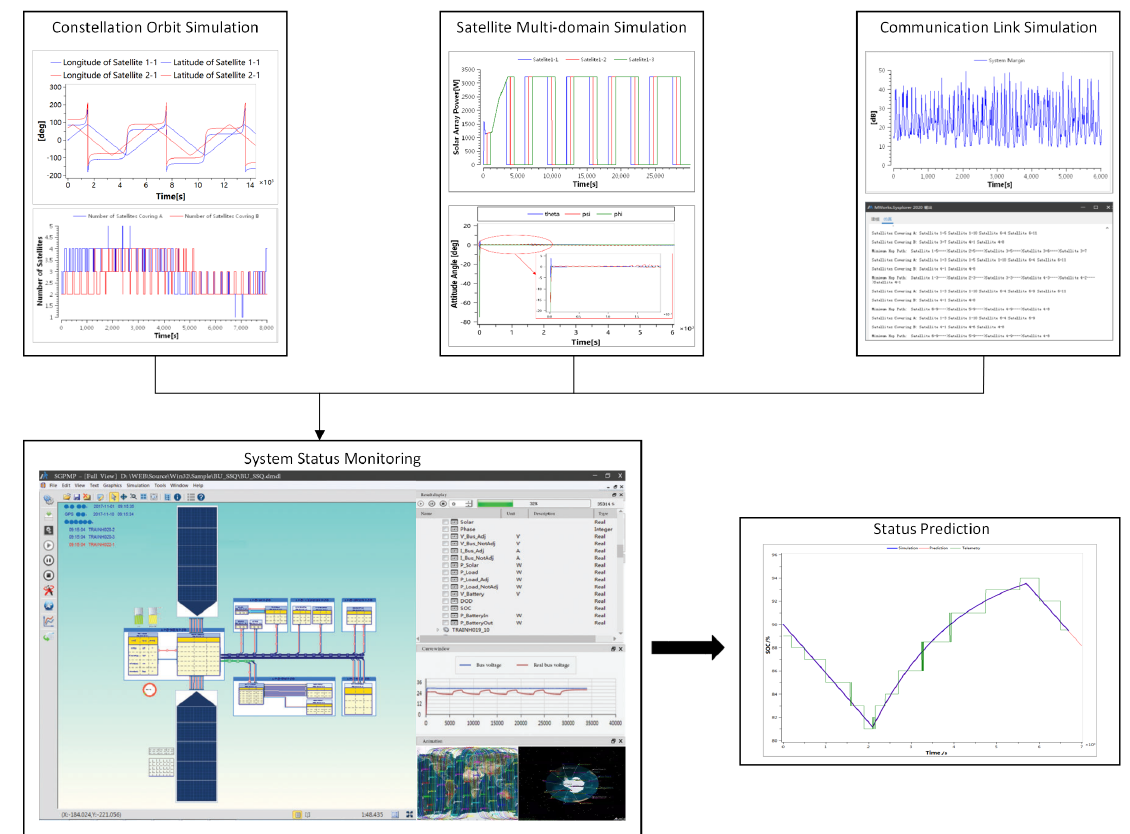
Figure 12. Simulation Results of PHM